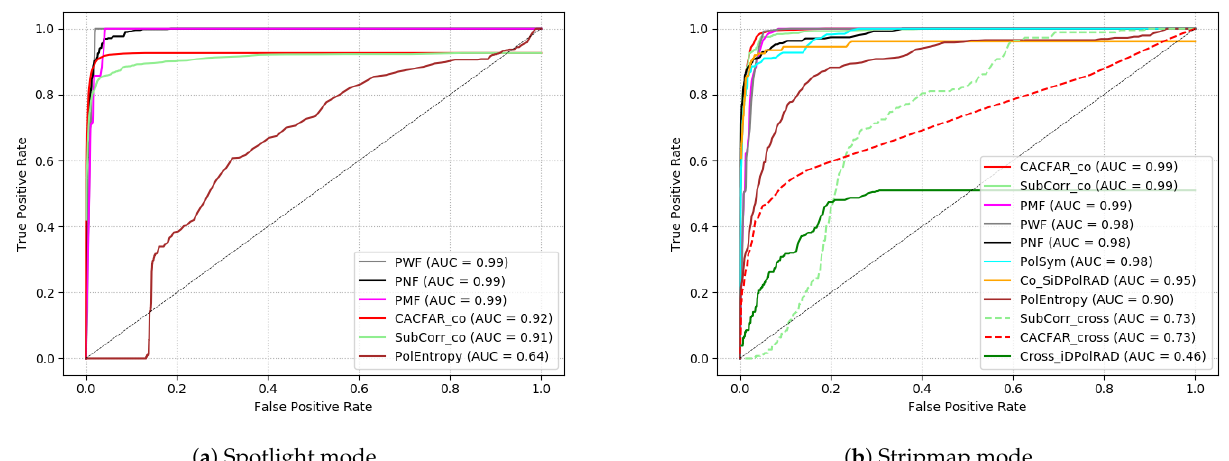
Figure 7. Comparing resolution: ROC curves for different acquisition modes (Pixel-based,